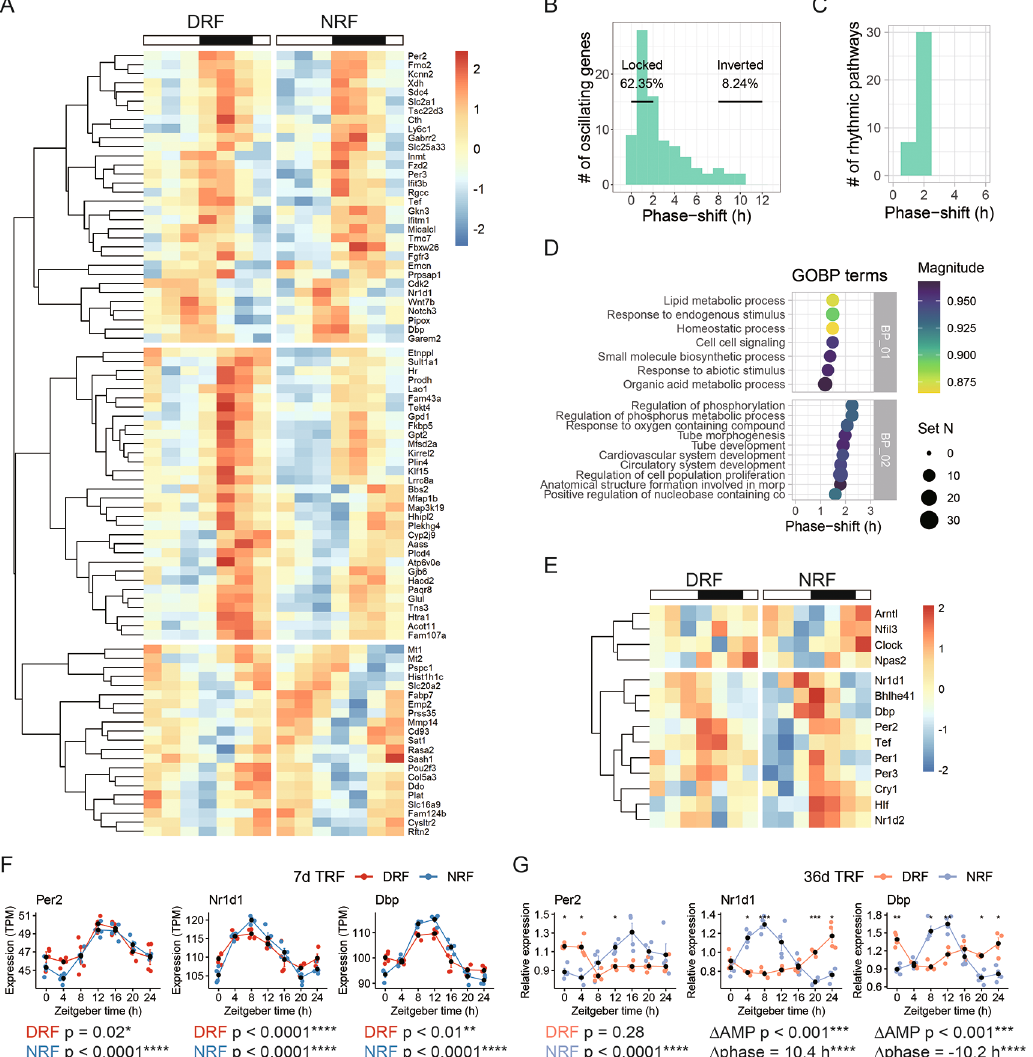
Figure 4. Food entrainment of the circadian clock in the anterior hypothalamus. (A) Hierarchical clustering analysis of rhythmic transcripts found in both DRF and NRF anterior hypothalamus. (B-C) Distribution of the phase- shift between DRF and NRF among (B) rhythmic transcripts or (C) enriched rhythmic pathways. (D) Representative enriched pathways based on shared rhythmic transcripts between DRF and NRF. (E) Hierarchical clustering analysis of the circadian clock genes. (F-G) Diurnal expression of selected clock genes in the anterior hypothalamus from female mice subjected to DRF or NRF for (F) seven days or (G) 36 days. Data are presented as mean (cid:1) SEM (n = 4 mice per time point). MetaCycle, *BH adjusted p-value < 0.05; Circacompare method, *p < 0.05, **p < 0.01, ***p < 0.001, ****p<0.0001.NRF,nighttime-restrictedfeeding ; DRF,daytime-restrictedfeeding;GOBP,geneontologybiological processes; Per2, Period circadian protein homolog 2; Nr1d1, Nuclear receptor subfamily 1 group D member 1; Dbp, D site-binding